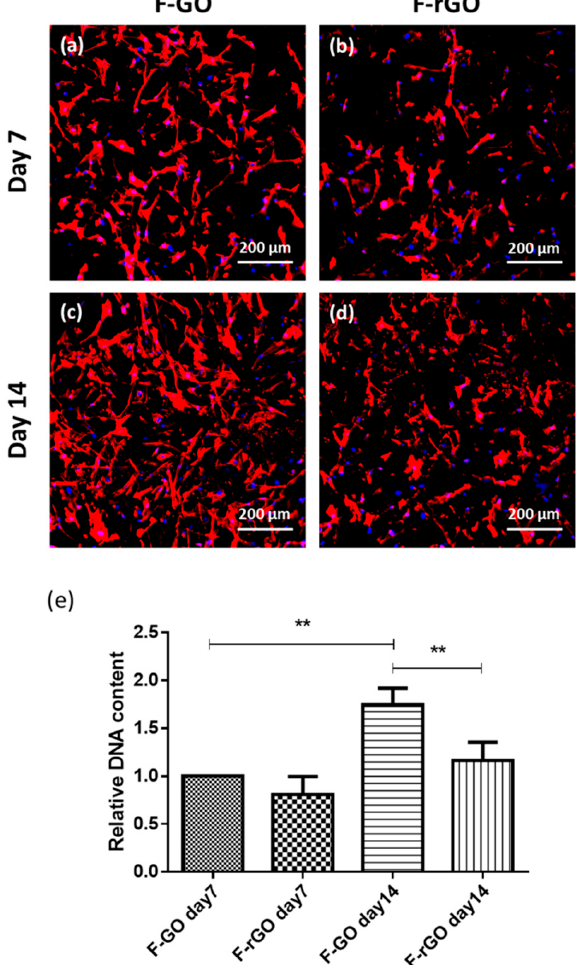
Figure 1. MSC growth on F-GO and F-rGO Frameworks. ( a – d ) MSC mono-cultures on F-GO or F-rGO on day 7 ( a , b ) and day 14 ( c , d ) visualized by confocal laser scanning microscopy after Phalloidin-TRITC staining. The scale bars represent 200 µ m. ( e ) The relative DNA content of MSCs on framework structures on day 7 and day 14. One-way ANOVA, ** p < 0.01, n = 3 Donors.